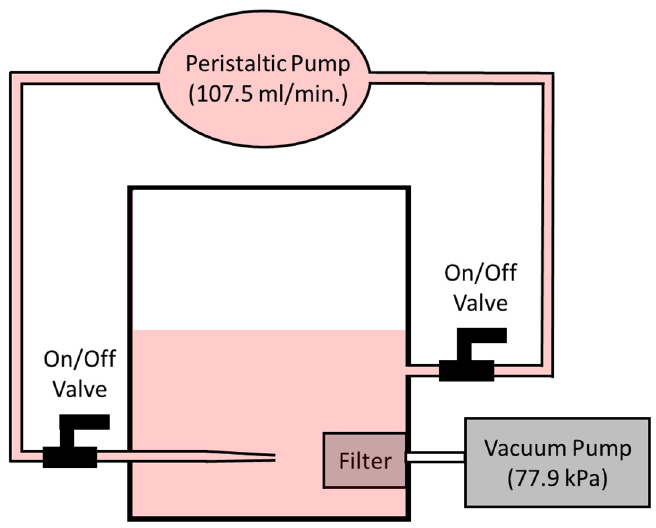
Figure 4. A diagram of the experimental filtration chamber setup.